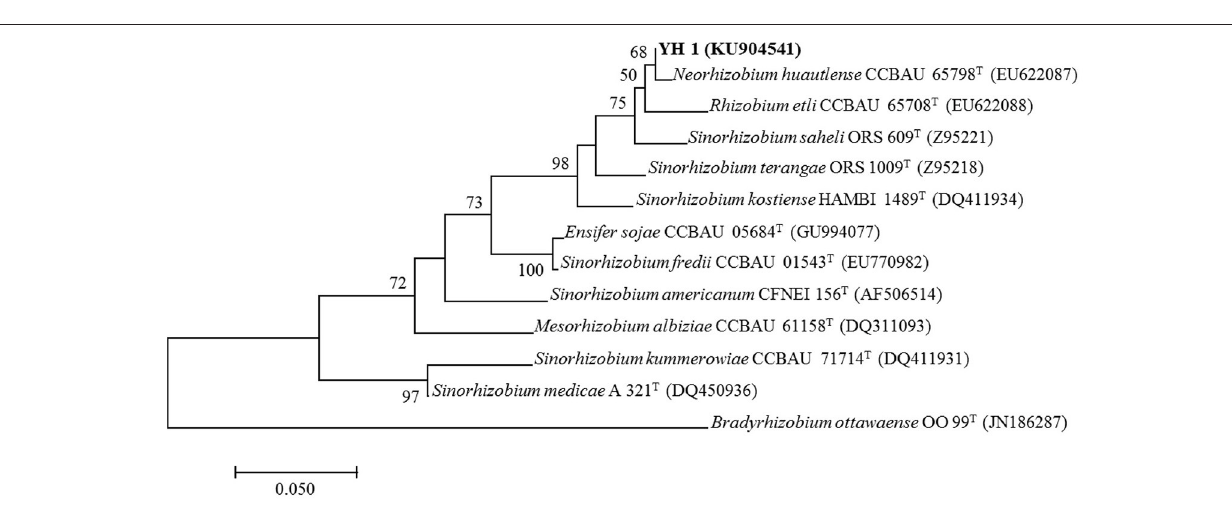
FIGURE 4 | Maximum likelihood tree of nifH sequences (453 bp) for L. leucocephala -isolated strain YH1 constructed using the Kimura 2-parameter model with bootstrap confidence based on 1,000 repetitions. Accession numbers retrieved from GenBank are shown in parentheses. The scale bar denotes 5% nucleotide substitutions per site. Values lower than 50 are not shown at the nodes. Superscript “T” following each strain number indicates type